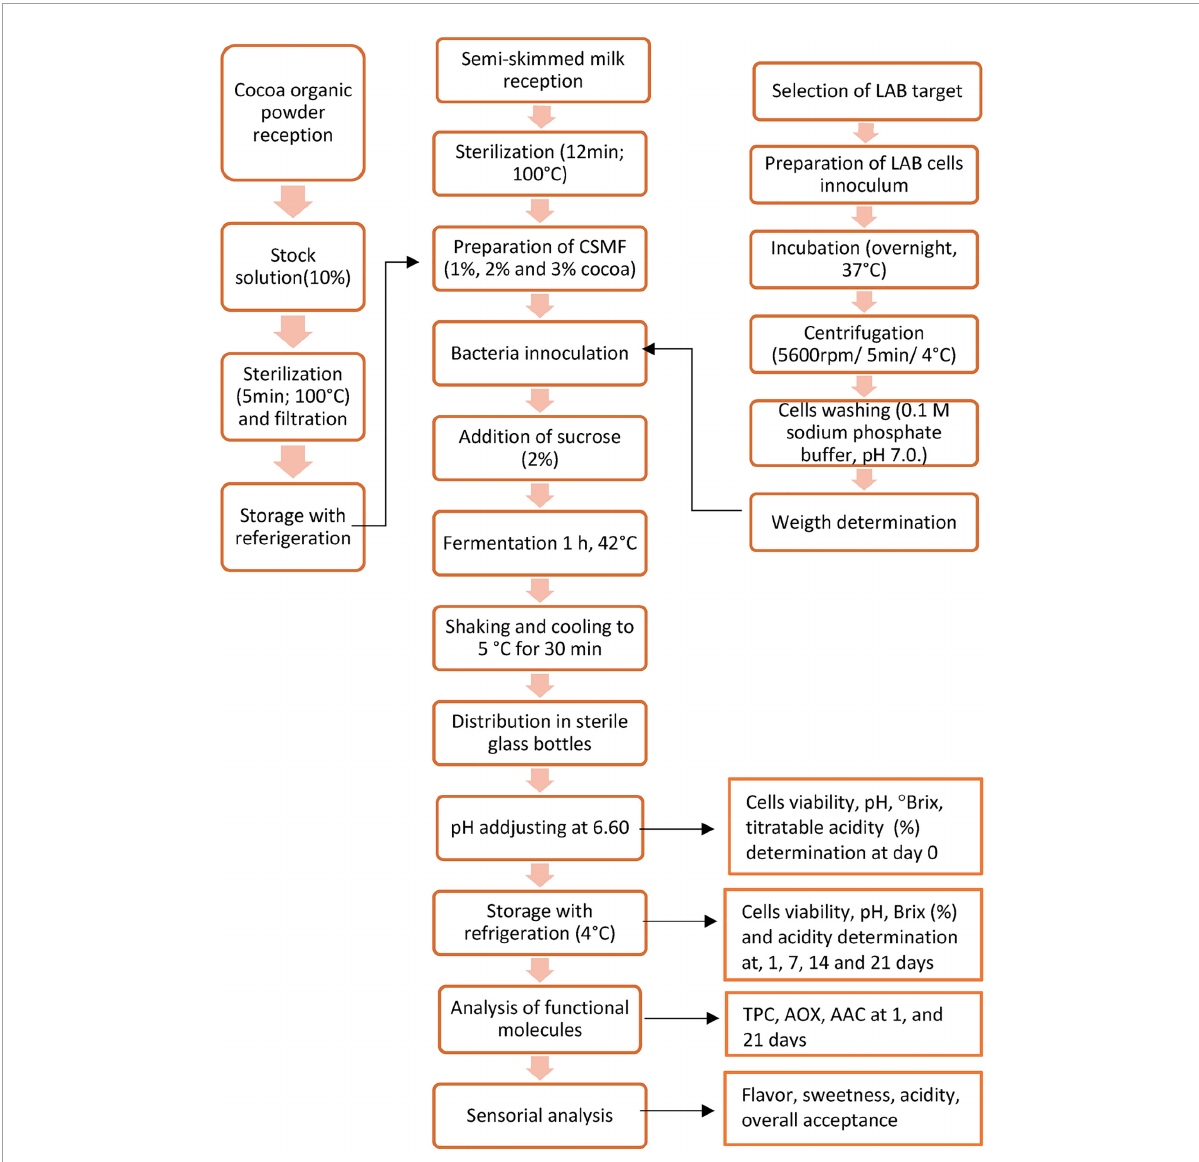
FIGURE1 Workflow of the manufacturing of cocoa-based semi-skimmed milk beverage supplied with LAB strains. Legend: LAB, lactic acid bacteria; CSMF, semi-skimmed milk + 1–3% cocoa + 2% glucose; TPC, total polyphenol content (equivalent milligrams of gallic acid (GAE)/L); AOX, antioxidant capacity (equivalent µ mol Trolox/L); AAC, ascorbic acid (equivalent mg acid